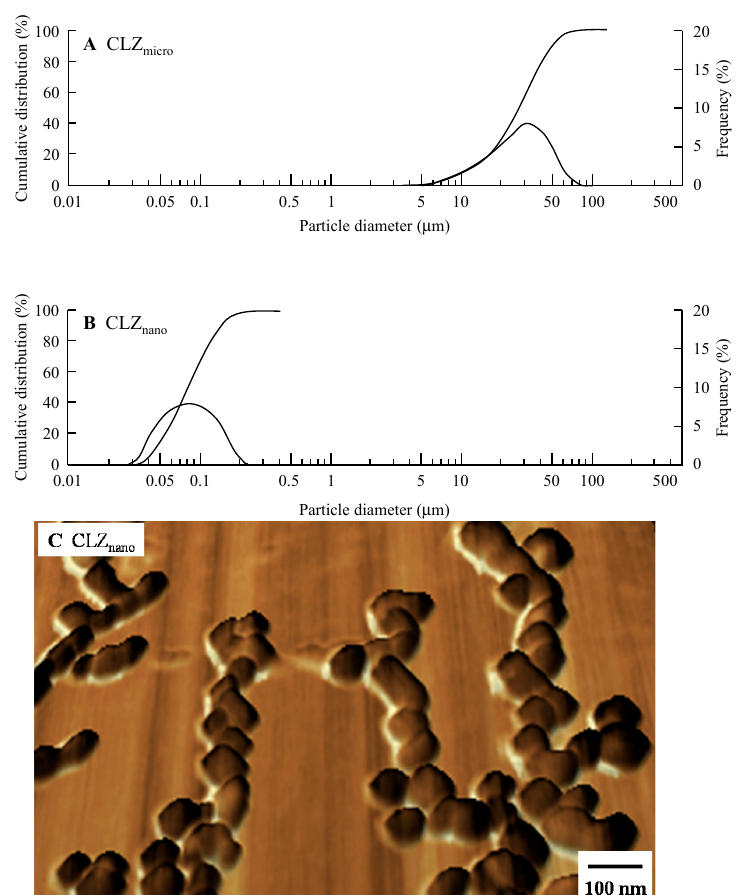
Figure 1. Cumulative size distribution, frequency and images of dispersions containing CLZ nanoparticles. ( A ) Cumulative size distribution and frequency of CLZ micro dispersion; ( B ) Cumulative size distribution and frequency of CLZ nano dispersion; ( C ) Image of the CLZ nano dispersion under the SPM-9700. The compositions of the preparations containing CLZ are shown in Table 1. Particle size and the image of the CLZ dispersions were determined using a nanoparticle size analyzer SALD-7100 and an SPM-9700, respectively.